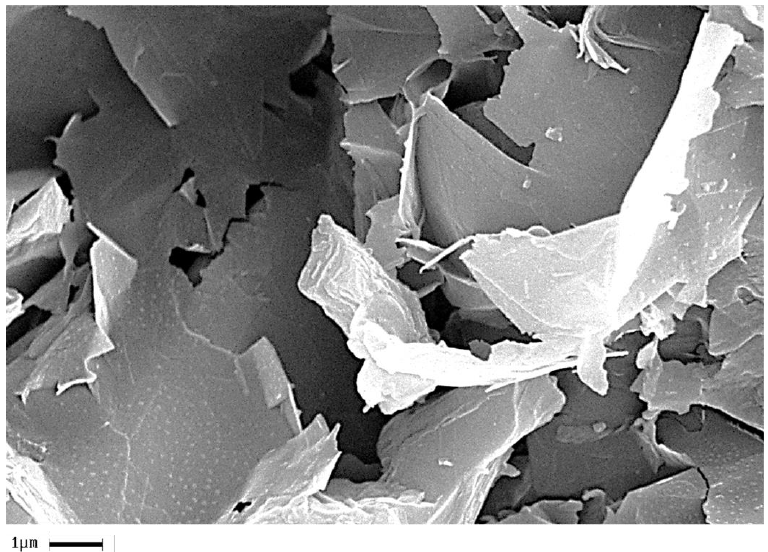
Figure 18. Fracture surface SEM image of the TBD + 3%EG sample.